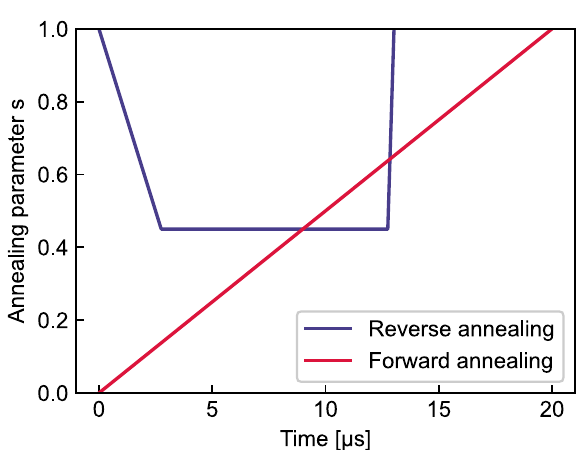
Figure 2. Annealing schedule of forward and reverse annealing. The red and blue lines indicate the chronological changes in annealing parameter s in forward and reverse annealing,